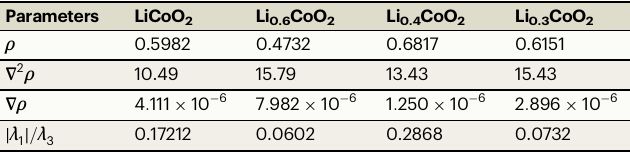
Table 1 | Topological analysis of the bond critical points along the Co – O bond in Li 1 − x CoO 2 Parameters